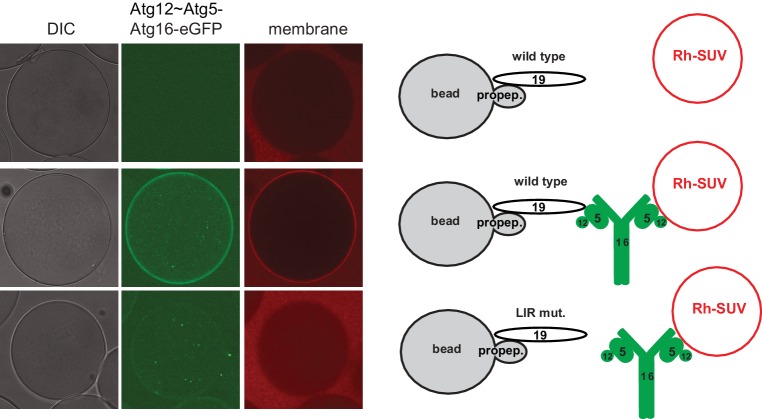
Atg19 AIM-dependent recruitment of the Atg12~Atg5-Atg16 complex and vesicles to cargo mimetic beads.Representative pictures and experimental scheme of Rhodamine-SUV recruitment to cargo mimetic beads coated with GST-prApe1(1–45) and Atg19 (wild type or AIM mutant (F376A, F379A, P385A, E386A, W412A)) with or without the Atg12~Atg5-Atg16-meGFP complex.